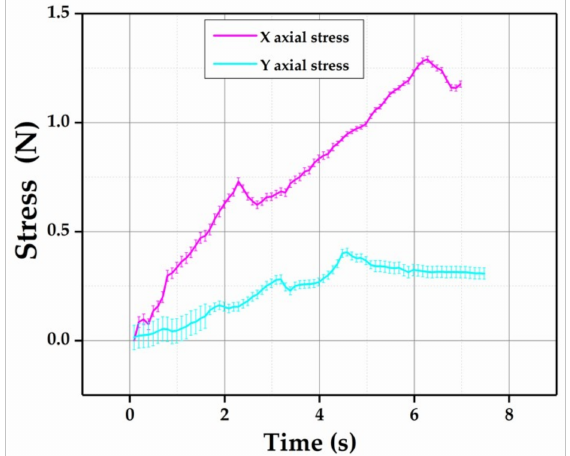
Figure 8. Standard deviation of data obtained from the